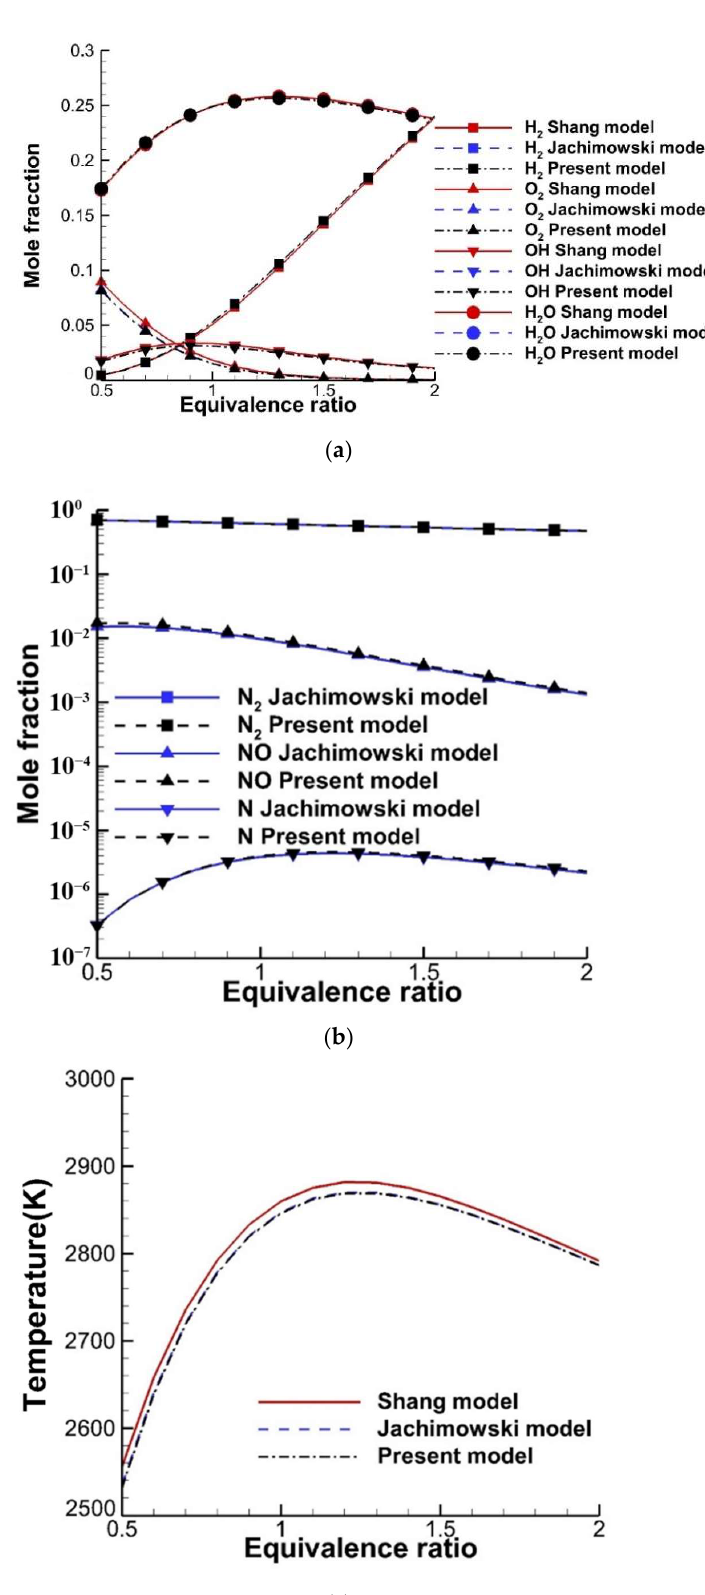
Figure 9. Ignition delay time varying with temperature at different initial pressures. ( a ) Initial pres- sure of 0.5 atm. ( b ) Initial pressure of 1 atm.